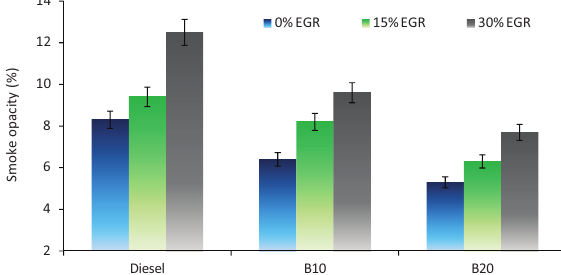
Figure 8. Effect of alcohol blends and different EGR rates on level of smoke opacity (%) under 1800